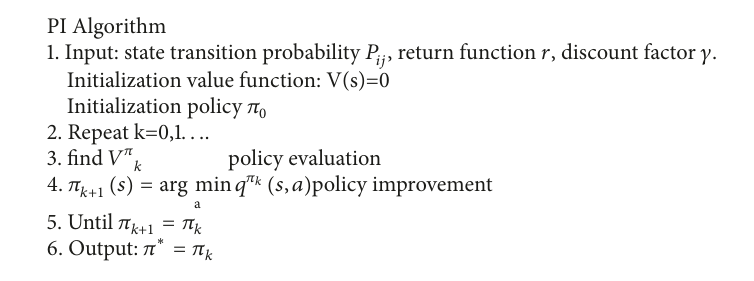
Algorithm 1: Flowchart of the PI algorithm.